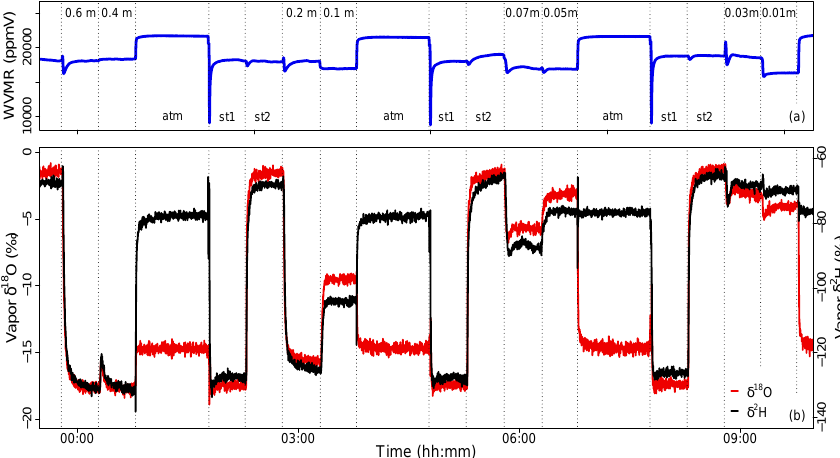
Figure 2. Water vapor mixing ratio (WVMR) and isotope composition ( δ 18 O and δ 2 H; [‰ VSMOW]) of the water vapor sampled on day of experiment 150 from the ambient air (“atm”), both standards (“st1” and “st2”), and from the tubing sections at soil depths 1, 3, 5, 7, 10, 20, 40, and 60cm.